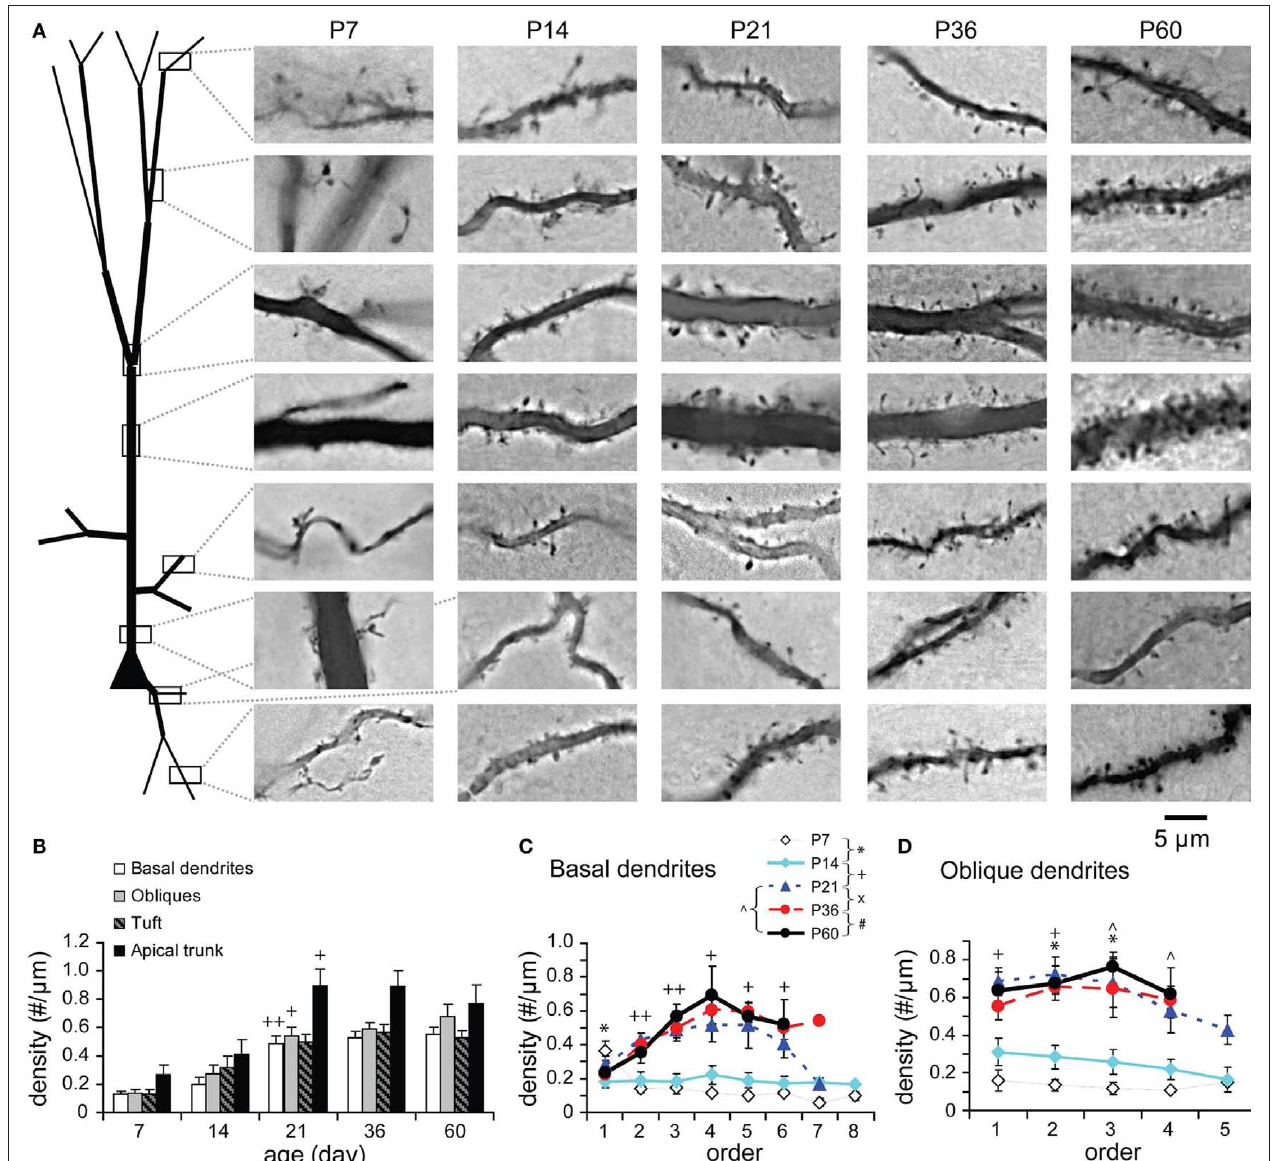
where the spine density was significantly reduced. From P14 to P21, the spine density significantly increased unevenly on different branch orders with a peak at the fourth order. Afterward, no significant changes were tested. (D) Spine density on oblique dendritic segments versus branching order at different ages [same cells as in (B) ]. At P7 and P14, spine density was also relatively uniform on different orders with a significant increase on the second and third orders from P7 to P14. At older ages starting from P21, spine density further increased unevenly on different orders with a peak at the middle (second or third) orders. The significant increases were at the first and second orders from P14 to P21 and at the third and fourth orders from P21 to